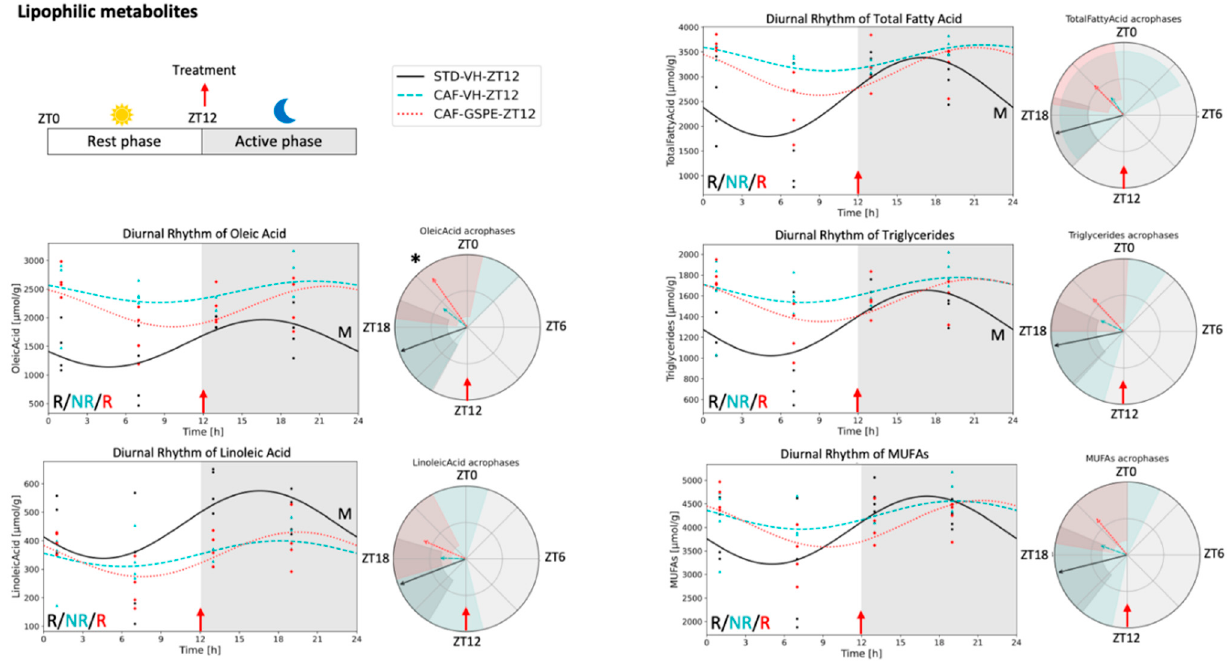
Figure 2. Lipophilic metabolites that recovered their diurnal rhythm loss under cafeteria diet in re- sponse to GSPE administration at ZT12. Circadian parameters such as rhythmicity, mesor, amplitude, and acrophase were calculated using the CircaCompare algorithm based on Cosinor. Graphs showing diurnal rhythm and acrophase were performed using the Python package based on Cosinor. R indicates significant rhythmicity; NR indicates non-rhythmic; M indicates significant mesor difference between STD-VH-ZT12 and both cafeteria diet groups; * indicates significant acrophase difference between STD-VH-ZT vs CAF-GSPE-ZT12. None of the metabolites presented differences between groups for amplitude.